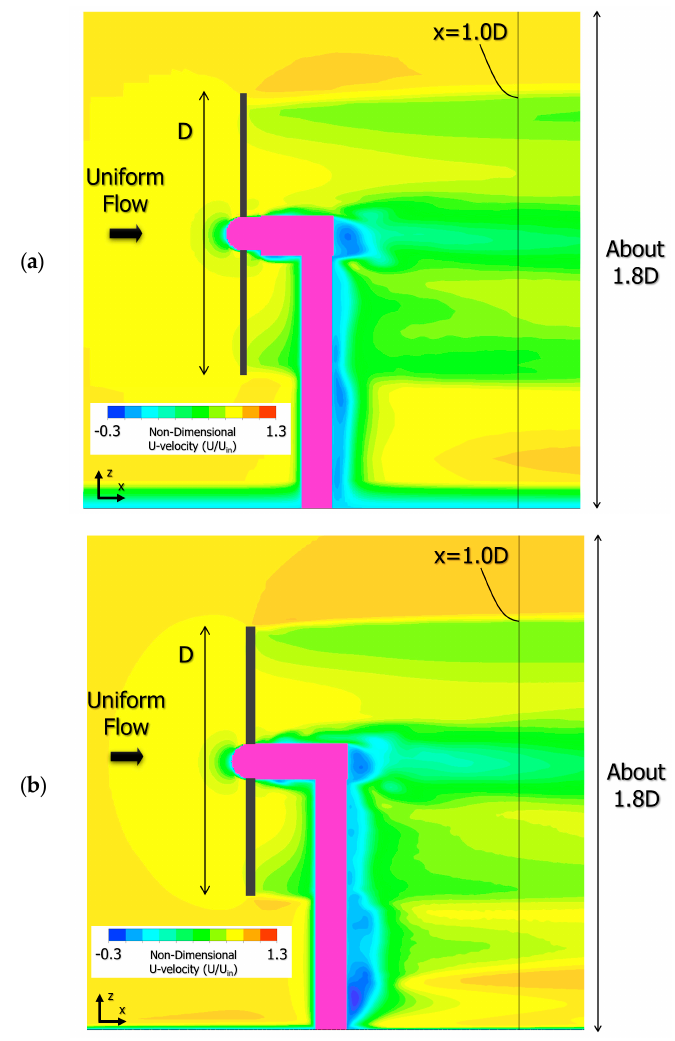
Figure A7. Comparison of spatial distribution of U-velocity for time-averaged flow field in the x–z plane (side view): ( a ) standard grid (same result as Figure 16c), and ( b ) fine grid.